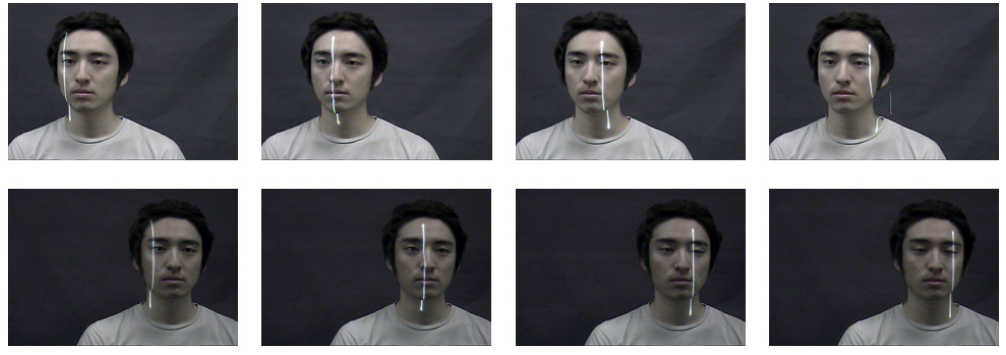
Figure 5. Captured sequential face images. The first and second rows represent captured images from right and left cameras, respectively.